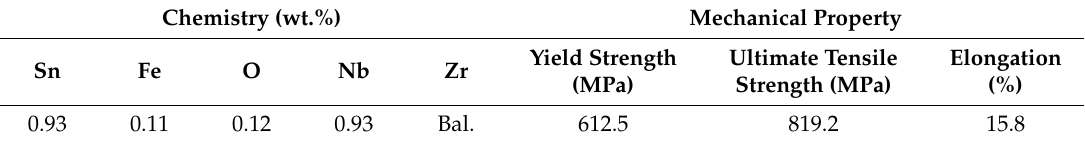
Table 1. Chemistry and mechanical properties of fuel cladding